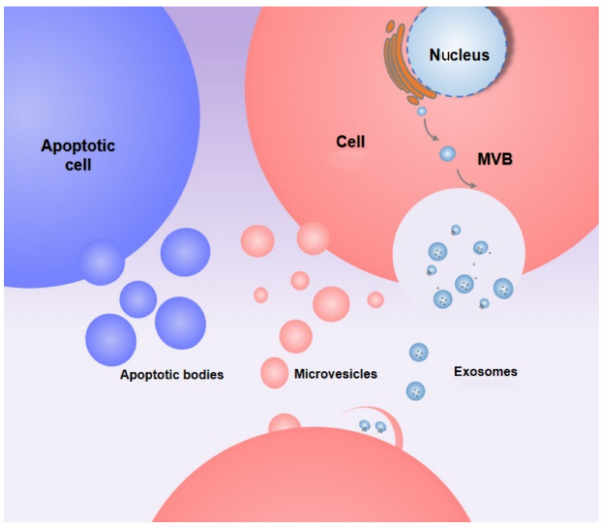
Figure 1. Biogenesis of different EV